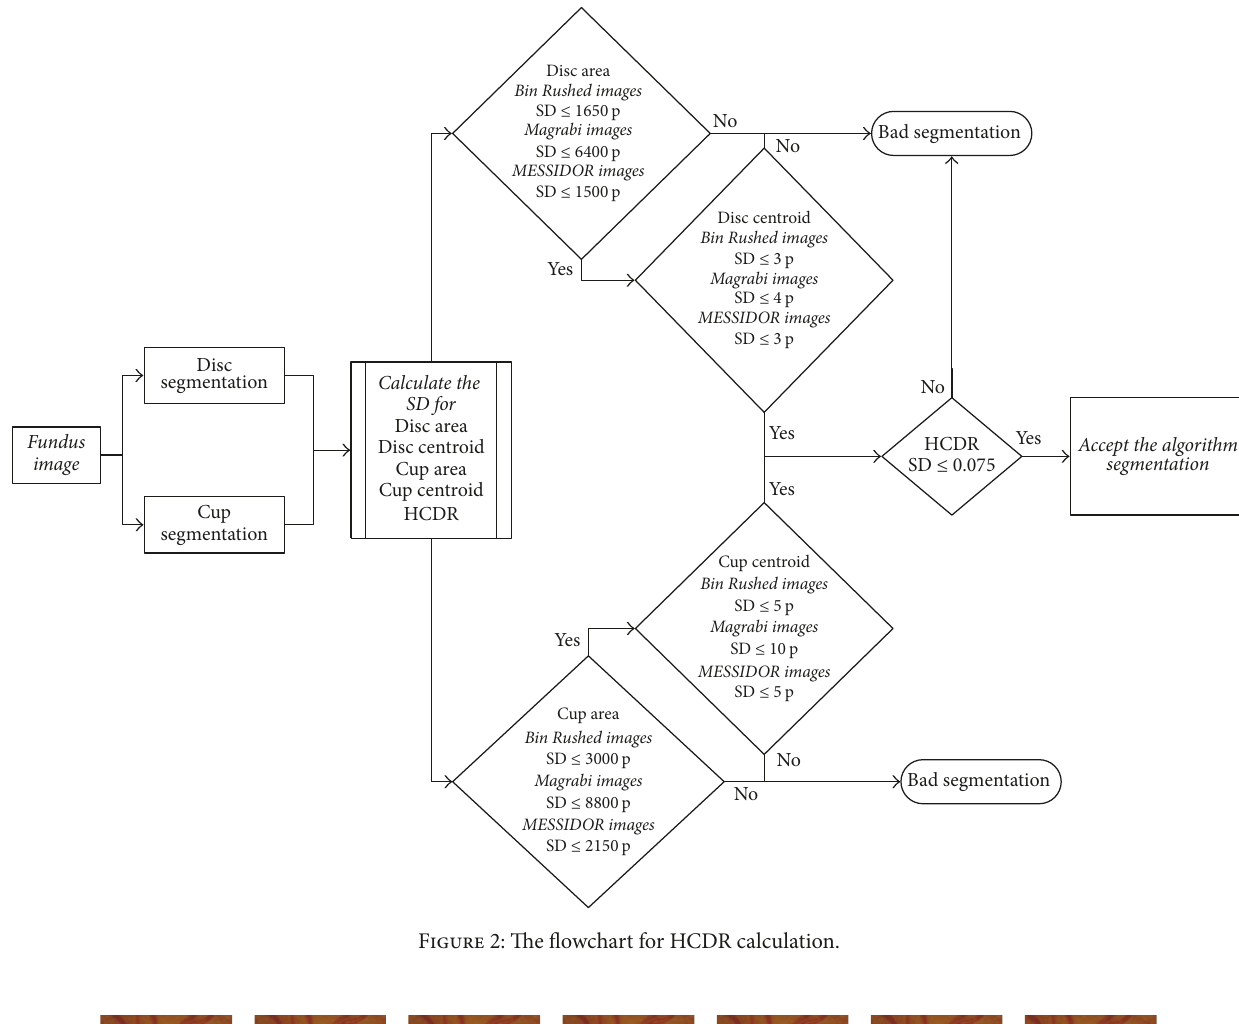
Figure 2: The flowchart for HCDR calculation.